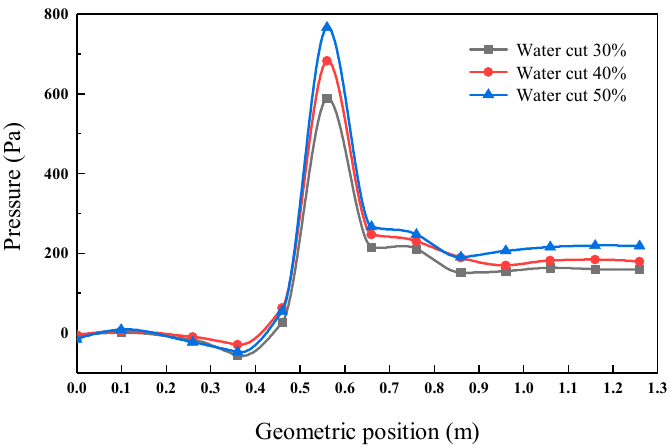
Figure 3. Effect of the water cut on the axial pressure distribution of a cylindrical cyclone.